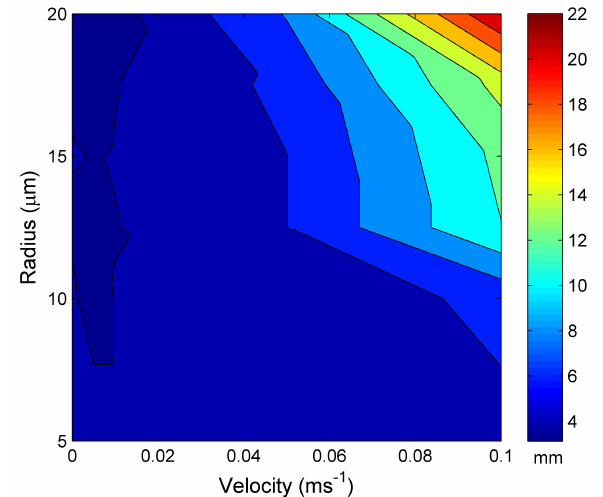
Figure 7. The distance taken to reach the steady-state length vs. the water hole radius and water input velocity at 60 ◦ C .